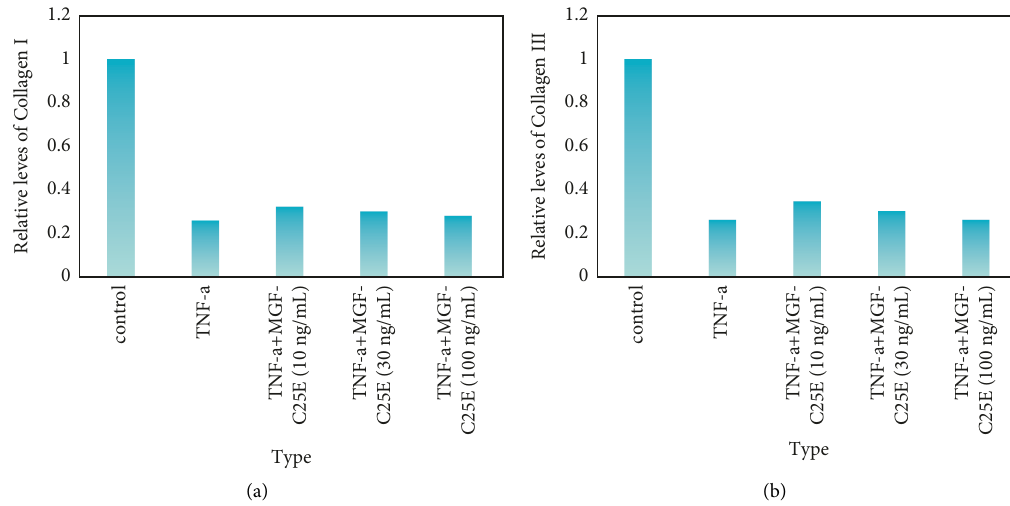
Figure 8: Effects of MGF-C25E on the expression of genes related to injured tenocytes. (a) Relative longevity of type I collagen. (b) Relative longevity of type III